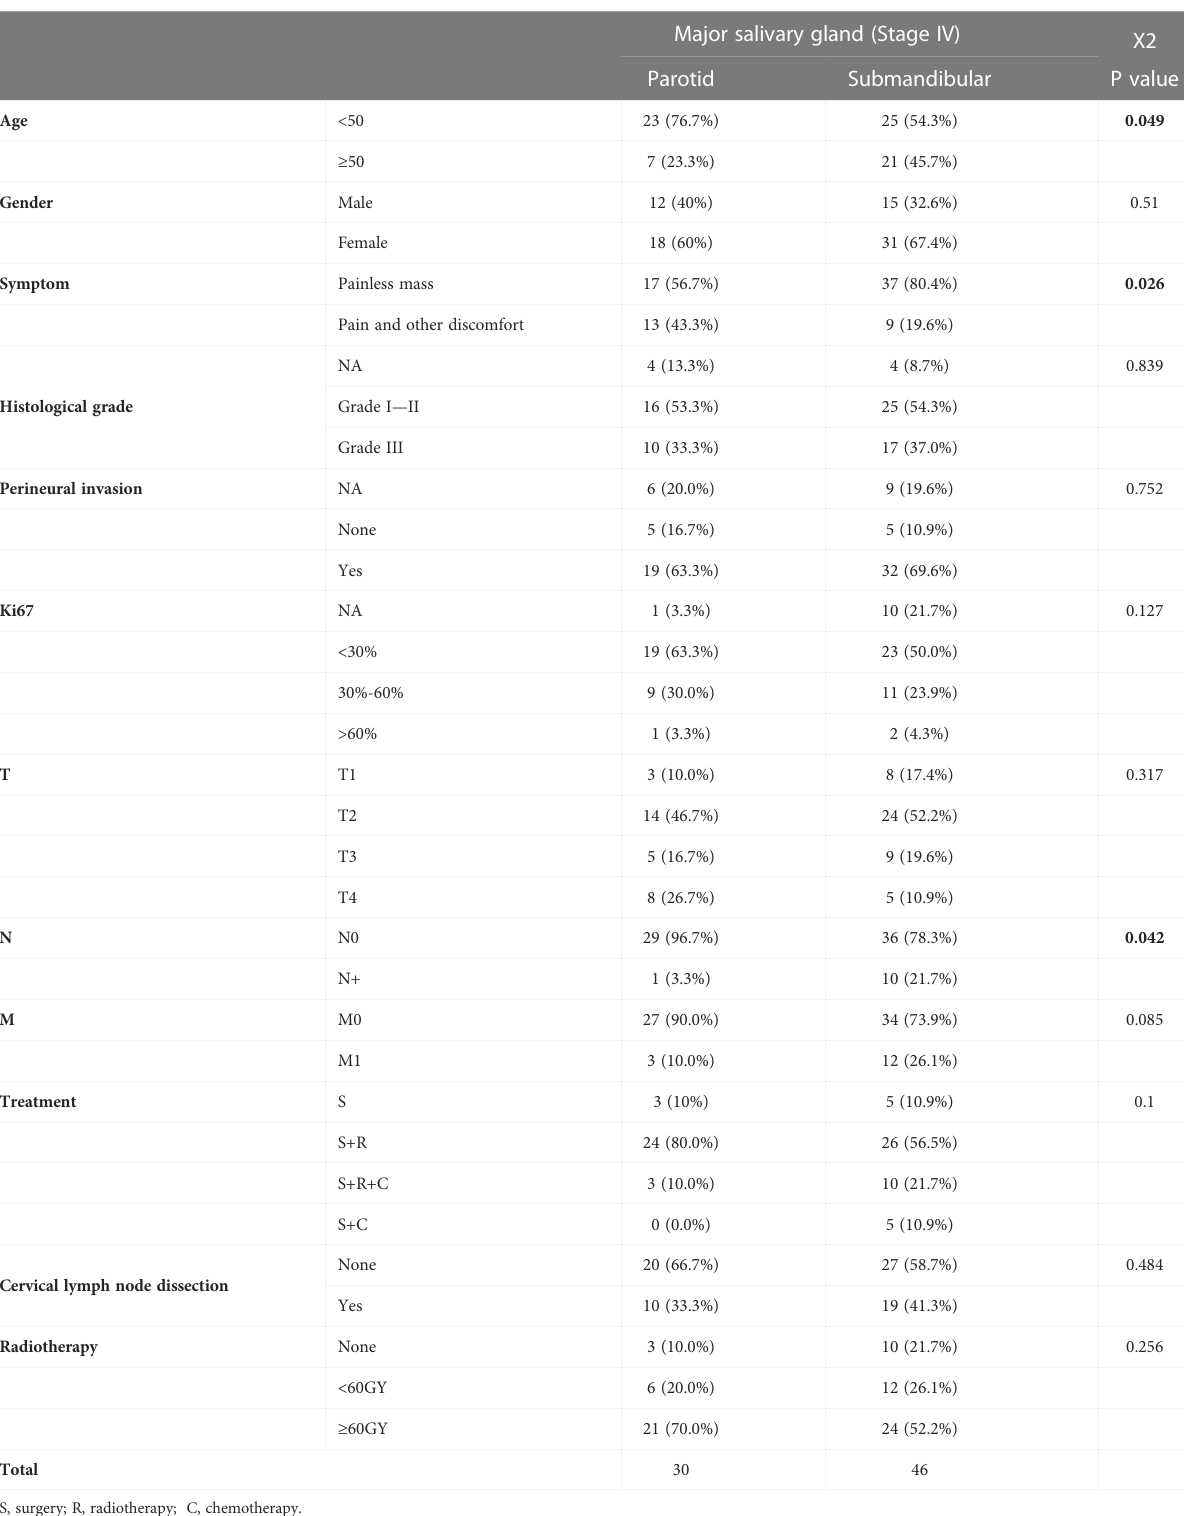
TABLE 2 Differences in the overall clinical characteristics of patients with submandibular and parotid glands ACC based on a single - centre retrospective